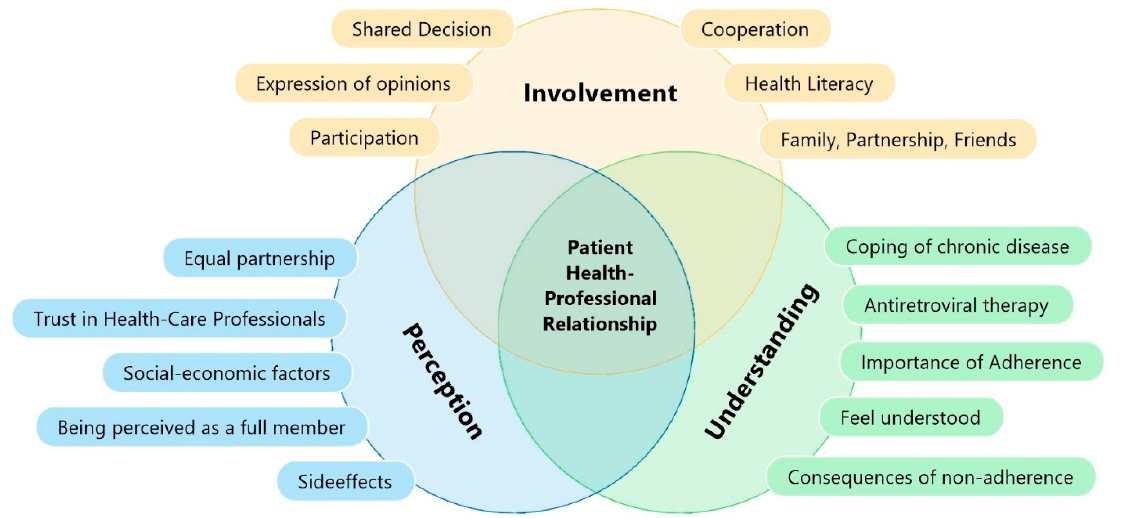
Figure 1. Multifactorial influences in communication on patient–healthcare professional relationship (own illustration).